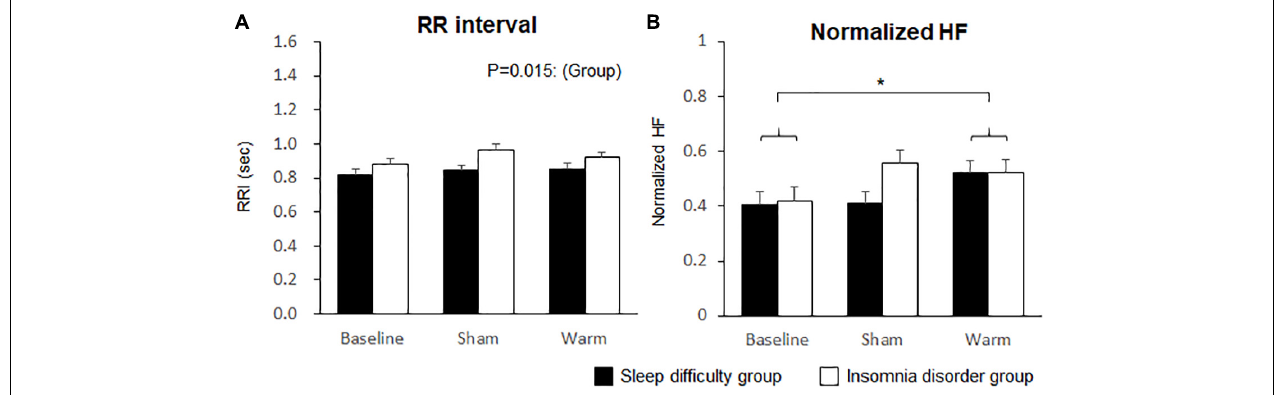
FIGURE 6 | Comparisons of heart rate variability between conditions. (A) RR interval. (B) Normalized high frequency (HF). Bars and error bars represent the mean ± standard error of the mean (SEM). * p <